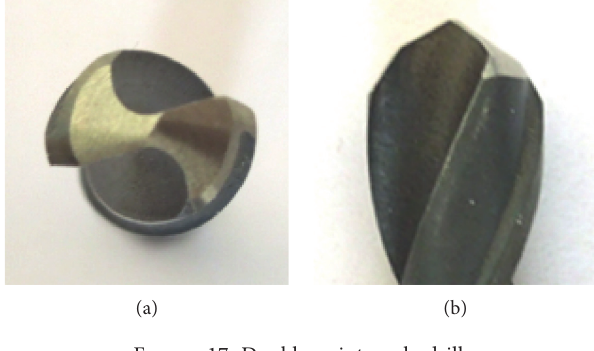
Figure 17: Double point angle drill.